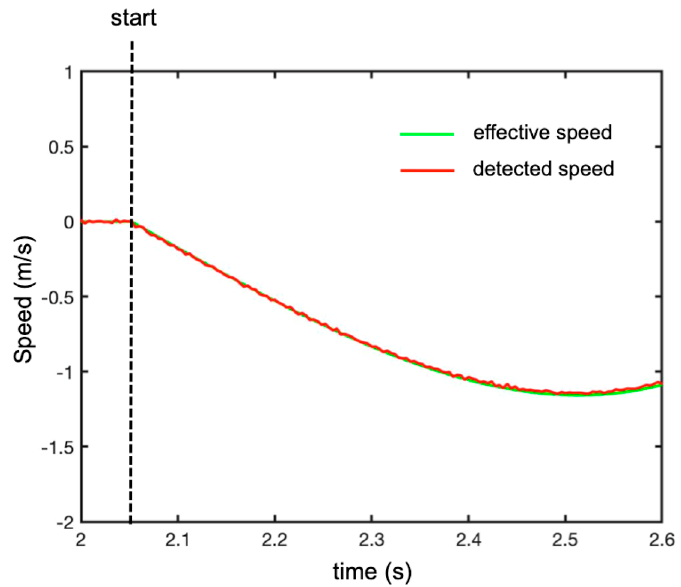
Figure 8. Speed of the falling target ( green line ) and the estimated speed by phase difference between two subsequent sweeps ( red line ).